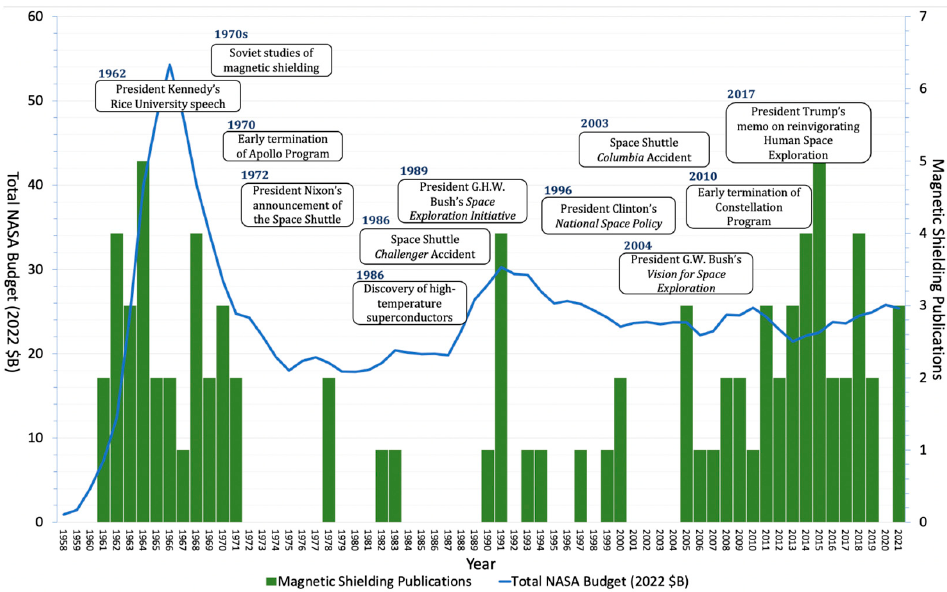
Figure 2. Timeline of magnetic shielding publications with additional contextual information .